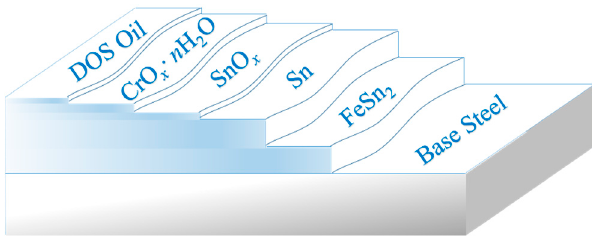
Figure 9. Schematic diagram of the ideal structure model of the tinplate surface and the interface.